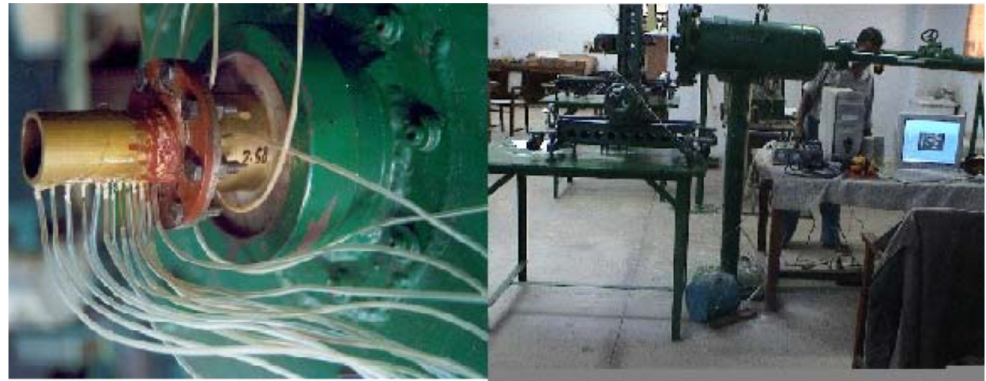
Figure 8. A view of the extended duct with pressure tapings and setup site [97]. Reprinted under the Creative Commons (CC) License (CC BY 3.0).